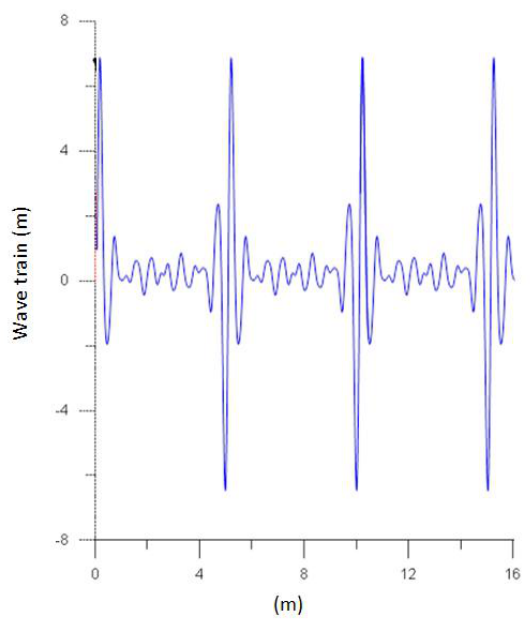
Fig. 4. Wave train profile. Axes have different units. For caption see Fig. 8.